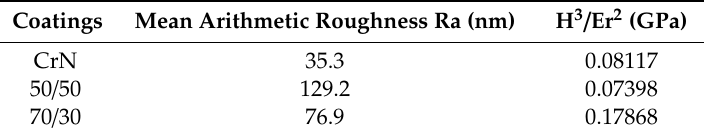
Table 2. Values of mean arithmetic roughness and H 3 / Er 2 .